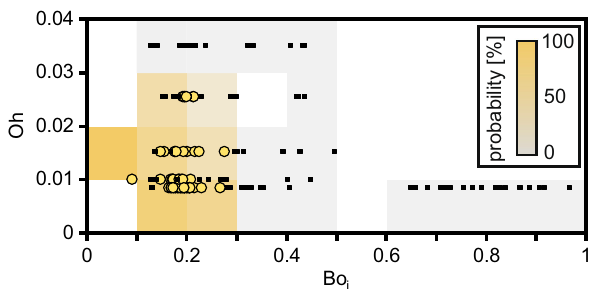
Fig. 4 Leidenfrost trampolining occurrence. The occurrence as a function of the initial Bond number, Bo i , and Ohnesorge number, Oh, is evaluated 1.4 s after gentle droplet deposition on concave silicon and sapphire substrates heated to T S ≈ 300 °C. Yellow circles show experiments where Leidenfrost trampolining was observed, while black squares represent the absence of Leidenfrost trampolining. Shading highlights the occurrence probability. n = 154 individual experiments. Source data are provided as a Source Data